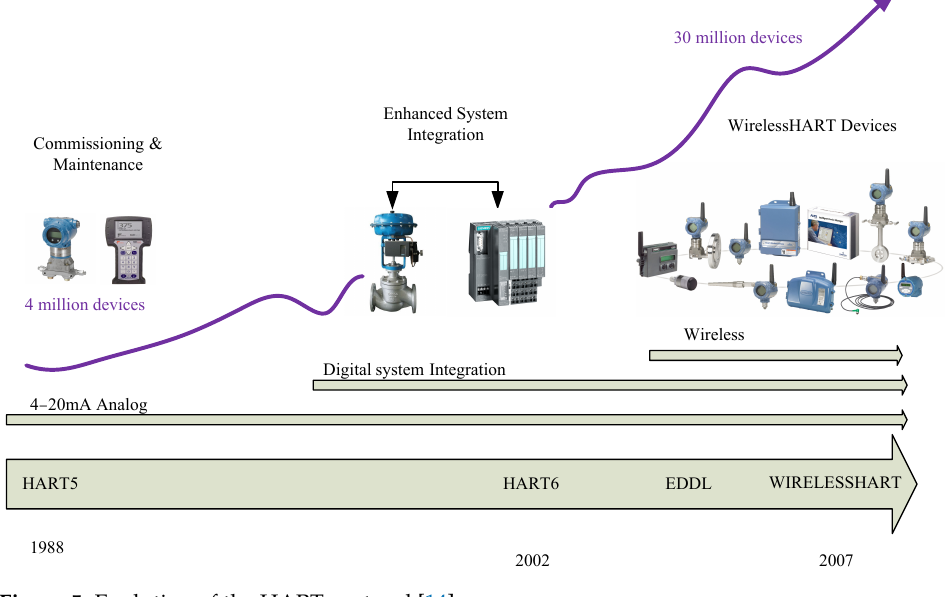
Figure 5. Evolution of the HART protocol